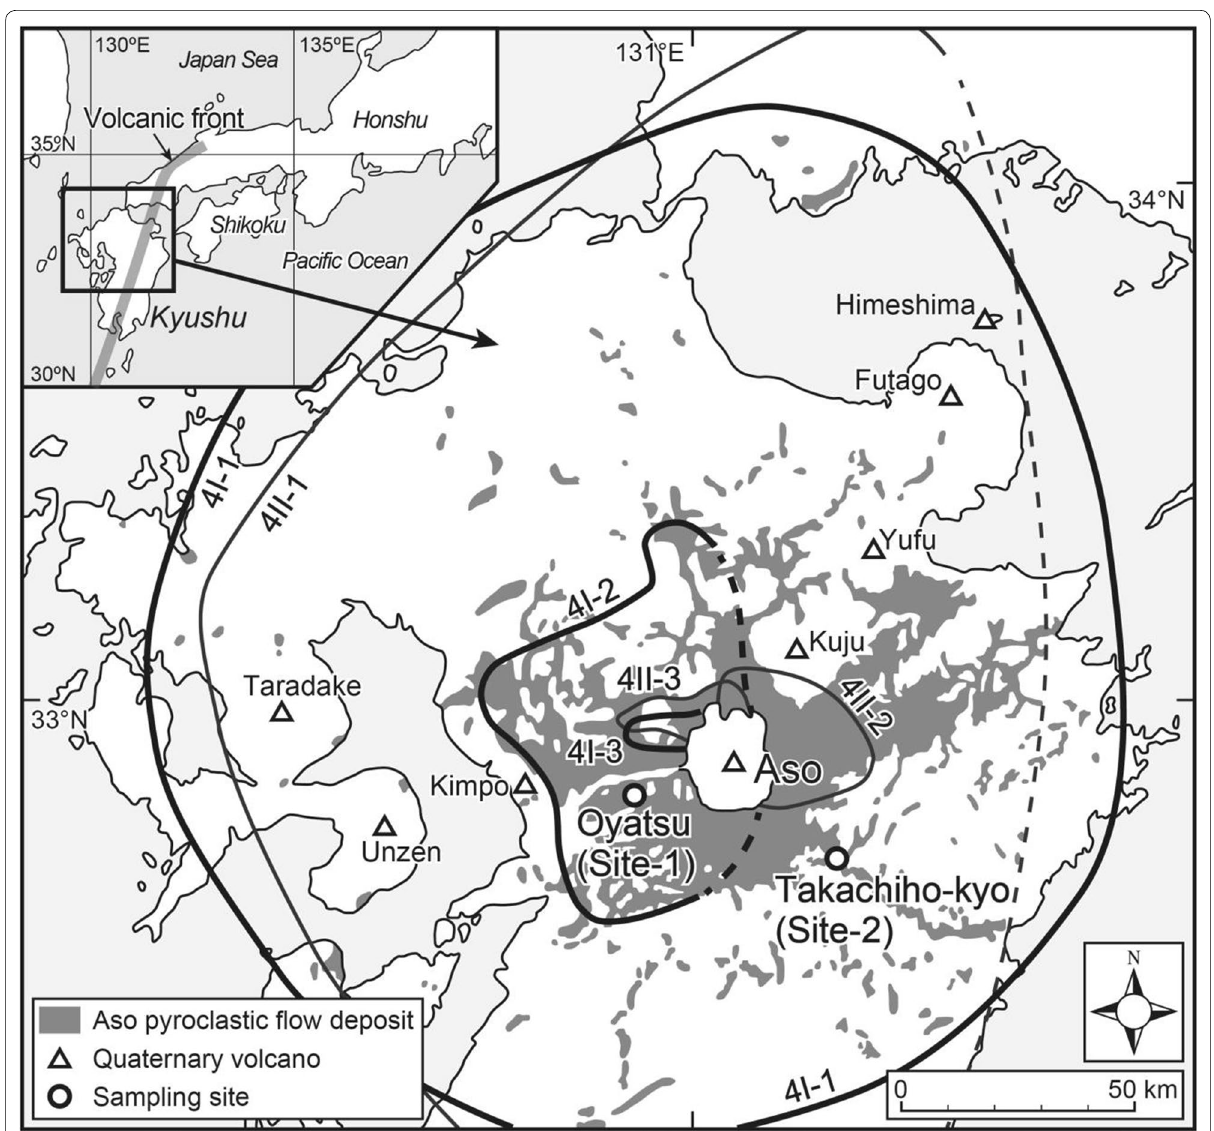
Fig. 1 Distribution of Aso-4 pyroclastic deposits and sampling sites (after Ono and Watanabe 1985; Kaneko et al. 2007). Solid lines show the distribution areas of Aso-4 pyroclastic flow units. Dashed lines show the estimated distribution areas of the units (Kaneko et al.